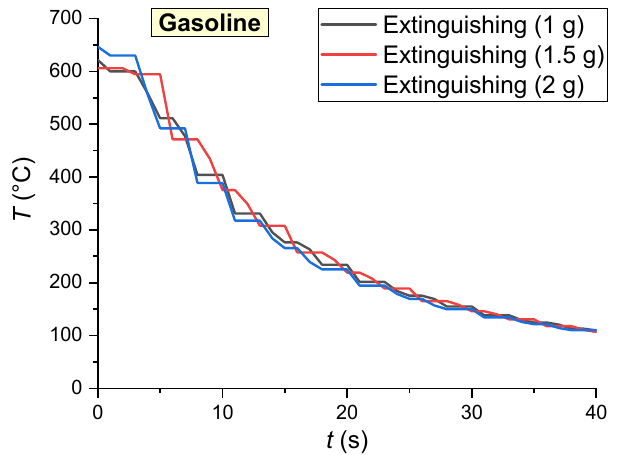
Figure 14. Combined experimental trends of the successful suppression of a laboratory-scale gasoline fire ( V 0 ≈ 3 mL, d f ≈ 50 mm, S f ≈ 20 cm 2 ) illustrating the flame temperature variation dynamics immediately after the discharge of the extinguishing agent—CO 2 hydrate powder—onto the fire. Figure 15 presents the temperature trends illustrating the flame temperature varia- tion dynamics of a laboratory-scale gasoline fire exposed to an extinguishing agent—CO 2 hydrate powder—with varying thickness of the fuel film (layer).